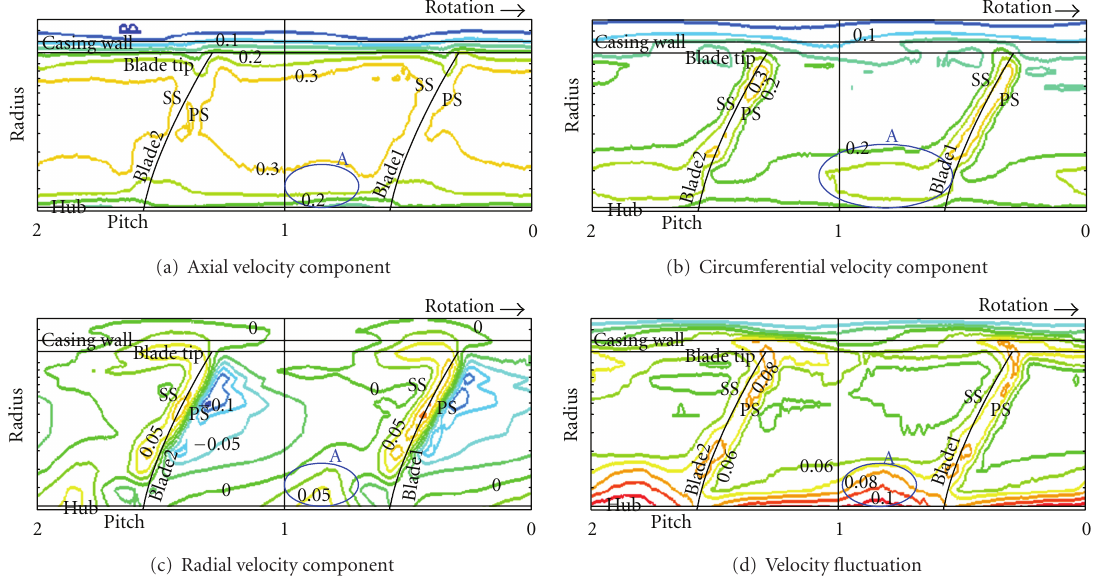
Figure 8: Contour maps of each velocity component and velocity fluctuation at rotor outlet of TypeA at φ = 0 .